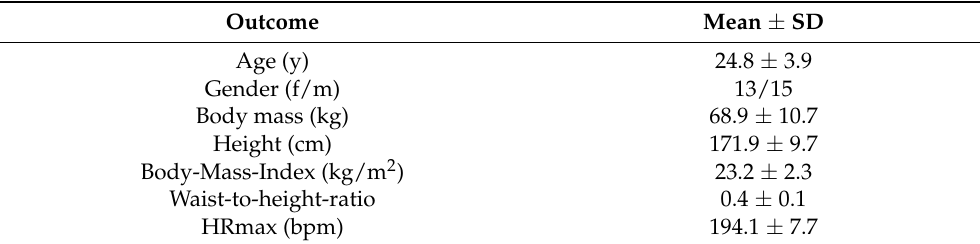
Table 1. Participants’ characteristics.